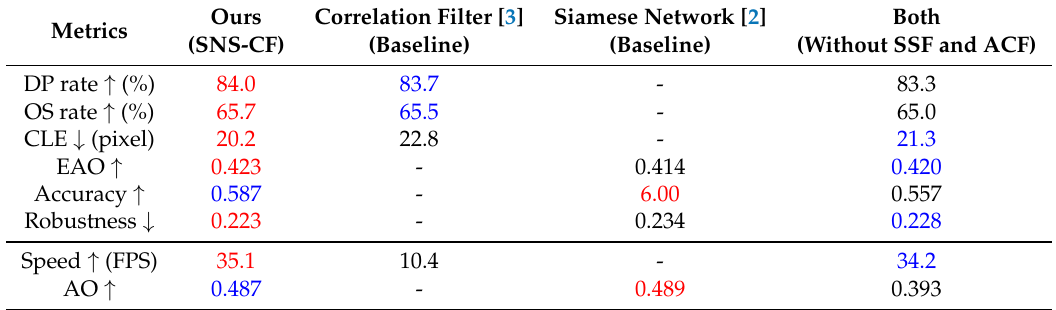
Table 3. Comparison with correlation filter, Siamese network, and the proposed SNS-FC algorithm that fuses both technologies. We present the results on VOT-2018 [9]. Red and blue numbers indicate the best and second best results,